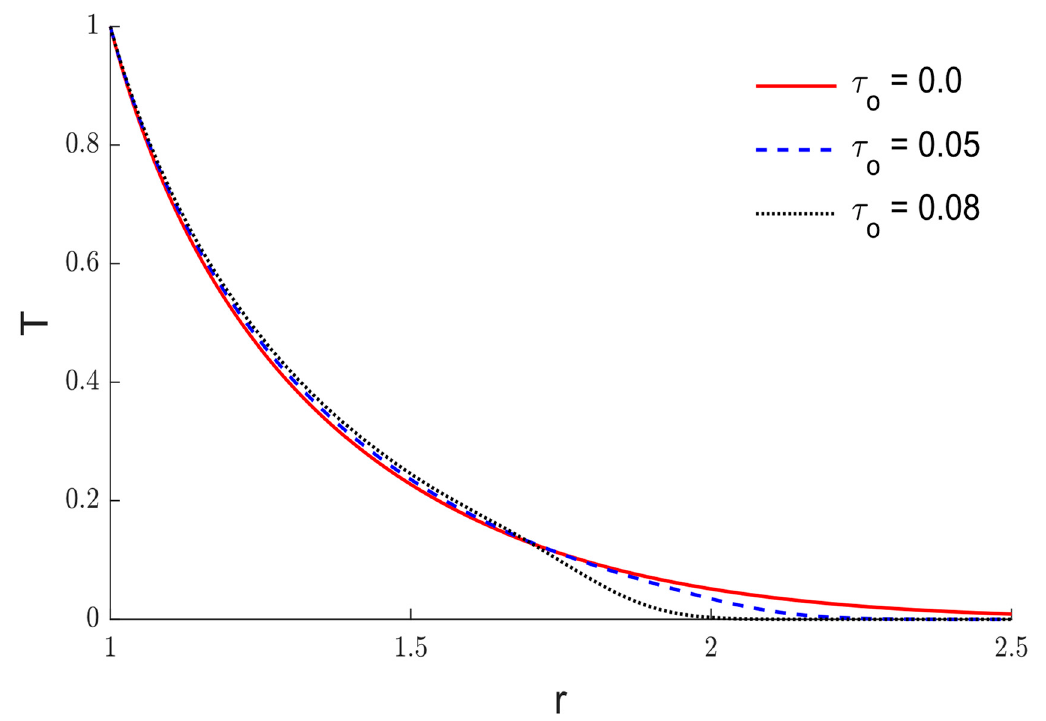
Figure 6. The impacts of thermal delay time τ o in the temperature variations T , when K n = − 0.6.